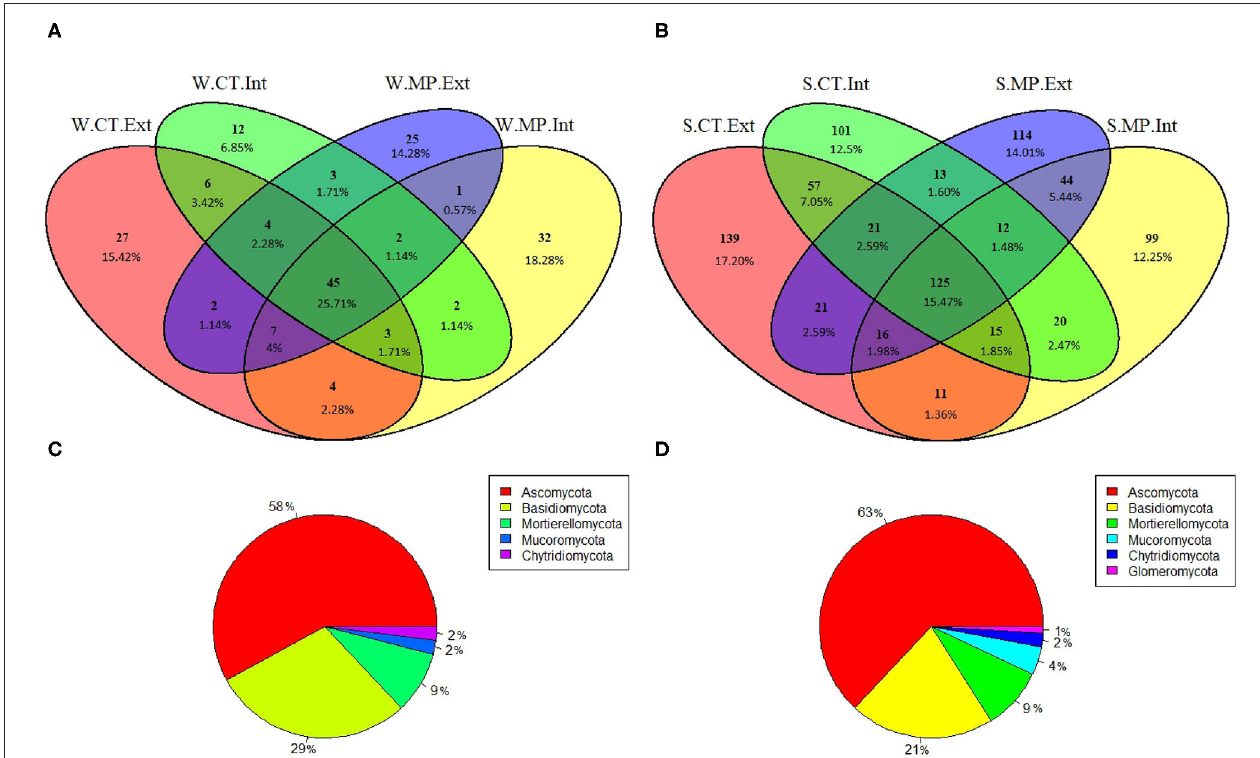
FIGURE 6 | Venn Diagrams (A,B) showing unique and shared fungal ASVs among treatments in soils sampled in LTE Bernburg in winter (W) or summer (S) under different long-term tillage practices (CT, Cultivator Tillage vs. MP, Moldboard Plow) and N-fertilization intensities (Int, intensive vs. Ext, extensive). Taxonomic classification (C,D) at phylum level of shared ASVs in winter or summer,